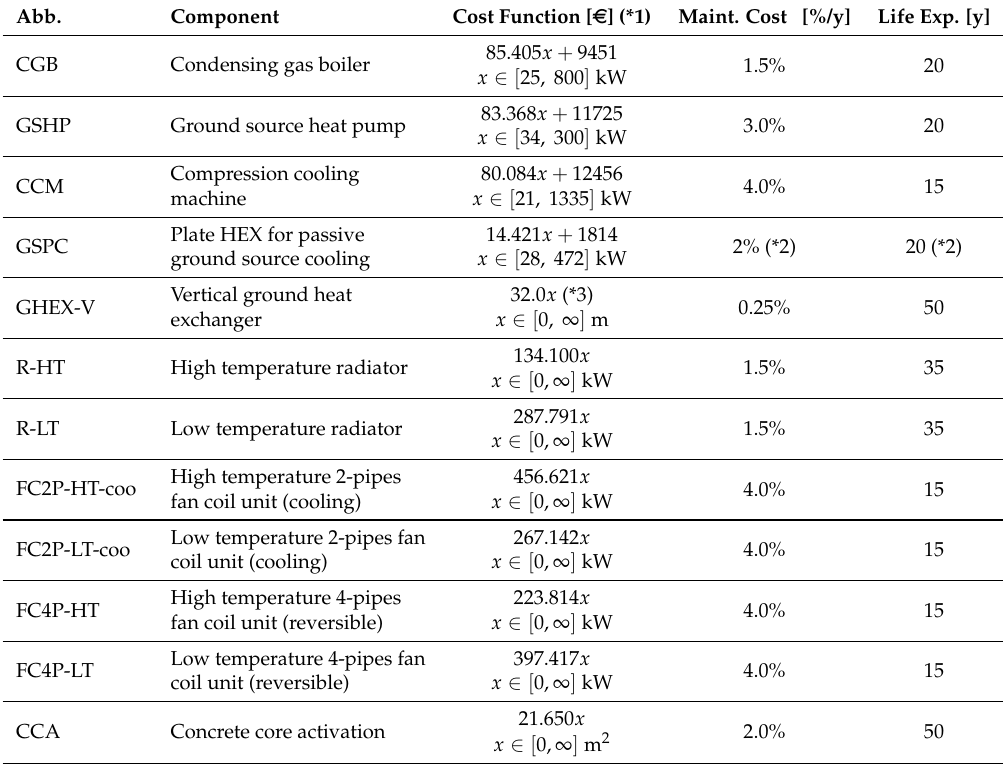
Table 1. Abbreviation (Abb.,) name, cost function with its lower and upper bounds ( ∞ means that extrapolation is allowed), Maintenance (Maint.) cost in percentage per year of the investment cost and Life Expectancy (Exp.) of each Heating, Ventilation and Air-Conditioning (HVAC) component, currently included in the